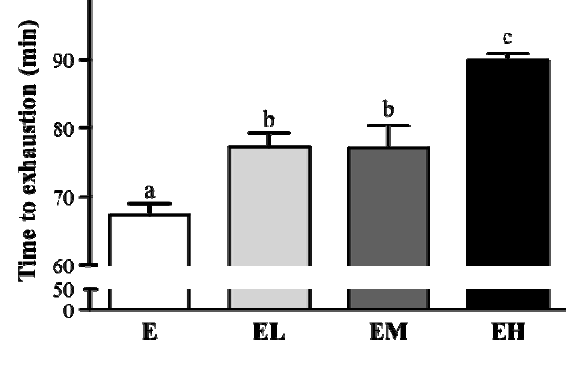
Figure 1. G. tsugae supplement effect on the running time to exhaustion. Male SD rats were pre-treated with 0, 0.1875, 0.9375, and 1.875 g/kg of G. tsugae (E, EL, EM and EH) for 30 days, and performed an exhaustive treadmill exercise. Data are presented as mean ± SEM of 6 rats in each group. Columns with different letters (a, b) differ significantly, p < 0.05 by one-way